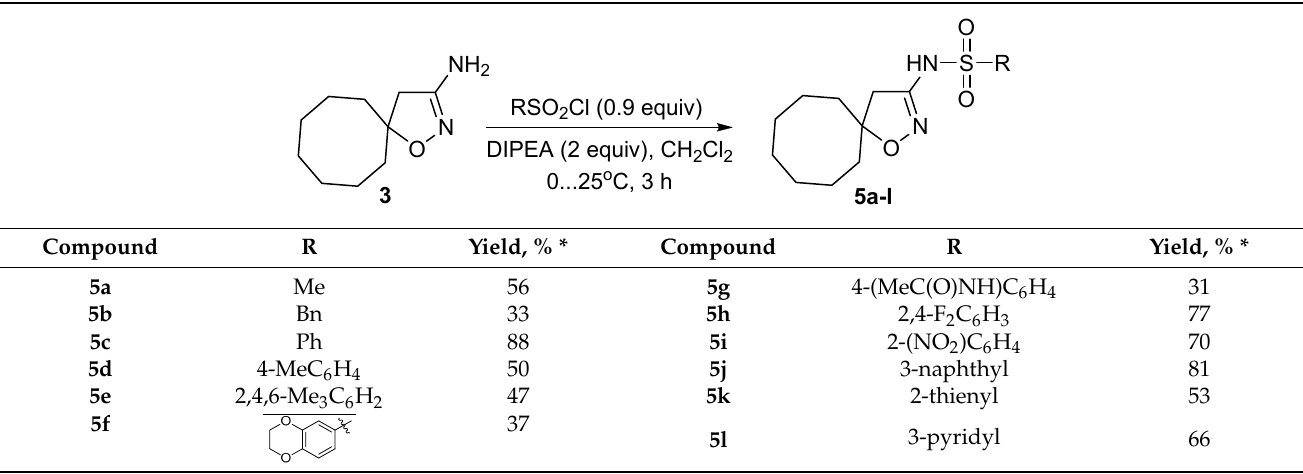
Table 1. Synthesis of sulfonamides 5a-l .